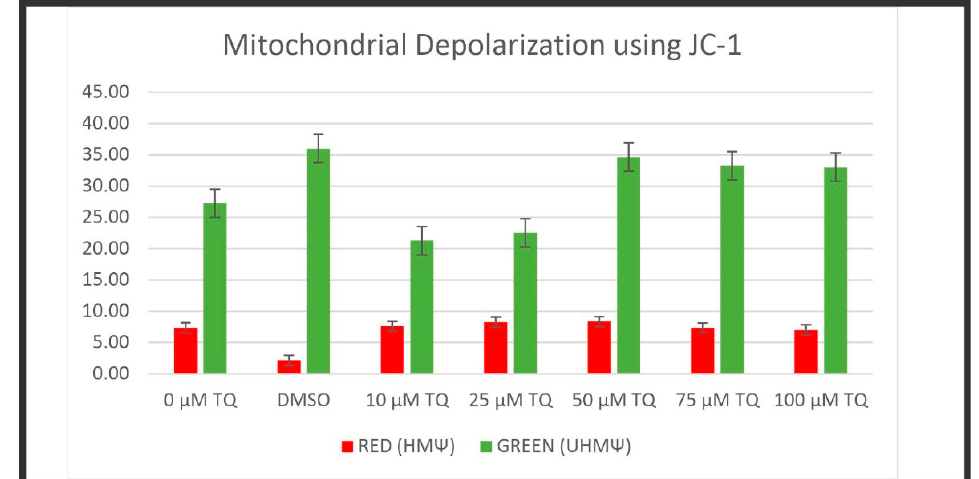
Figure 11. Mitochondrial depolarization using JC-1 for HuCCT1 using image analysis is demonstrated for DMSO and several concentrations of TQ. Three independent experiments were carried out for each concentration. A decrease in the red (~590 nm)/green (~529 nm) fluorescence intensity ratio after exposure to TQ is indicative of depolarization/disruption of the mitochondrial membrane. Three independent experiments were carried out for each concentration. Red means healthy mitochondria (HM Ψ ) while green means unhealthy mitochondria (UHM Ψ ). The variation in the mitochondrial depolarization is significant ( p < 0.001, two-tailed test).